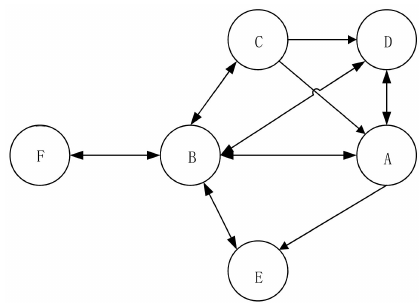
Figure 4. Shrinkage Network of Cohesive Subgroup of Tianjin Explosion.